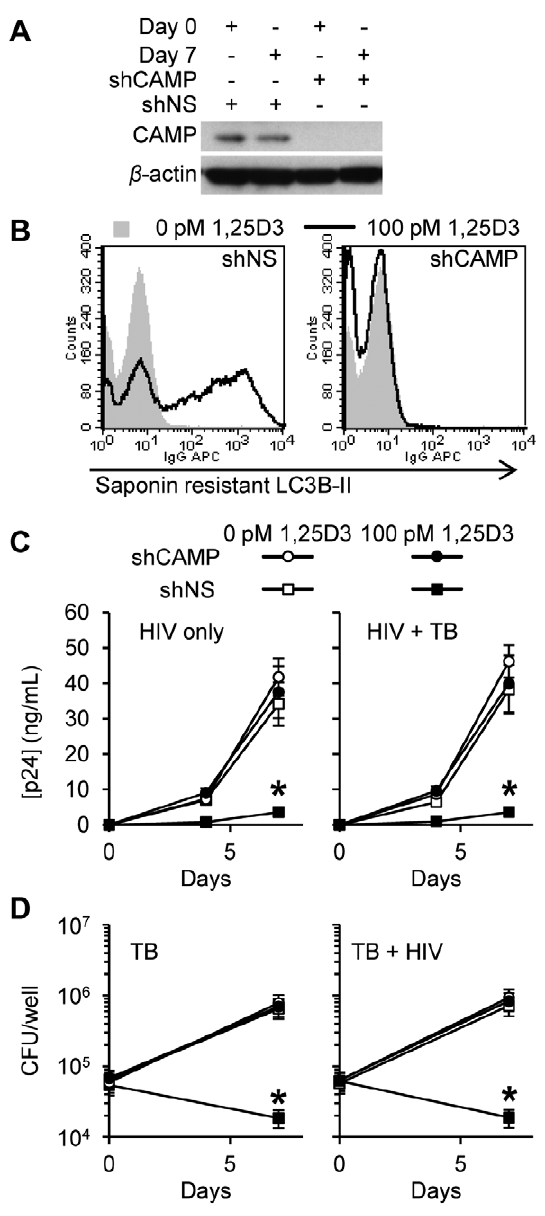
Figure 8. Inhibition of HIV and M. tuberculosis by 1,25D3 is CAMP and autophagy dependent. MDM were transduced with non-specific scrambled shRNA (shNS) or CAMP shRNA (shCAMP) and selected using puromycin resistance. Five days later, cells were incubated with 100 pmol/L 1,25D3 or vehicle control for 4 h before infection with HIV and/or M. tuberculosis (TB) for 3 h. Cells were then washed and incubated with 100 pmol/L 1,25D3 or vehicle control for 7 days. (A) Immunoblot analysis performed using antibodies raised to CAMP or b -actin after initial pathogen exposure (Day 0) or after 7 days. (B) Day 7 HIV-1 Ba-L and TB co-infected cells were harvested and stained for saponin-resistant LC3B-II at day 7. A representative histogram from three donors are shown. (C) ELISA performed for HIV p24 antigen release over 7 d. (D) Intracellular mycobacteria were harvested and assayed for mycobacterial growth by cfu enumeration at day 0 and day 7. All bar and line graphs are reported as mean 6 s.e.m. of three independent experiments performed in triplicate. * P ,